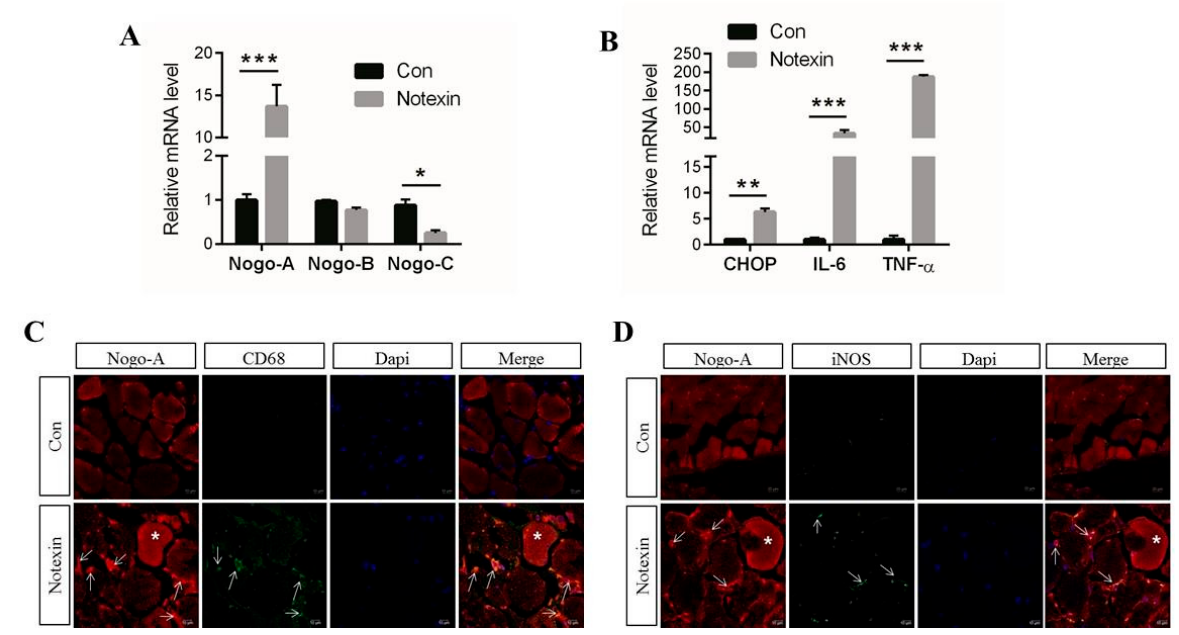
Figure 4. Expression of Nogo-A, CHOP, and pro-inflammatory factors is increased in muscle from notexin-treated mice. ( A ) Nogo-A is upregulated in injured muscle, while levels of Nogo-B and C are not significantly altered. Notexin-injured muscle expresses higher levels of Nogo-A compared with those in the WT control ( n = 3). ( B ) Expression of Nogo-A, CHOP, IL-6, and TNF- α is upregulated in notexin-injured muscle ( n = 3). ( C ) Notexin-injured muscle was immunostained using antibodies against Nogo-A and CD68 ( n = 3). Nogo-A is localized to muscle fibers (asterisk) and colocalizes with CD68 (arrow). ( D ) Notexin-injured muscle was immunopositive for Nogo-A and iNOS ( n = 3). Nogo-A is localized to muscle fibers (asterisk) and colocalizes with iNOS (arrow) 3 days after a single intramuscular injection of notexin (12.5 μ g/mL, 20 μ L). Data were normalized to RNA expression of GAPDH. Data are shown as the mean ± standard error of the mean. The statistical significance was determined using Student’s t -test. Data are denoted by asterisks, where * p < 0.05, ** p < 0.01, and *** p < 0.001. Secondary antibodies used were Alexa Fluor (AF)-555 and AF-488. Scale bar, 10 μ m, ×400 mag- nification.